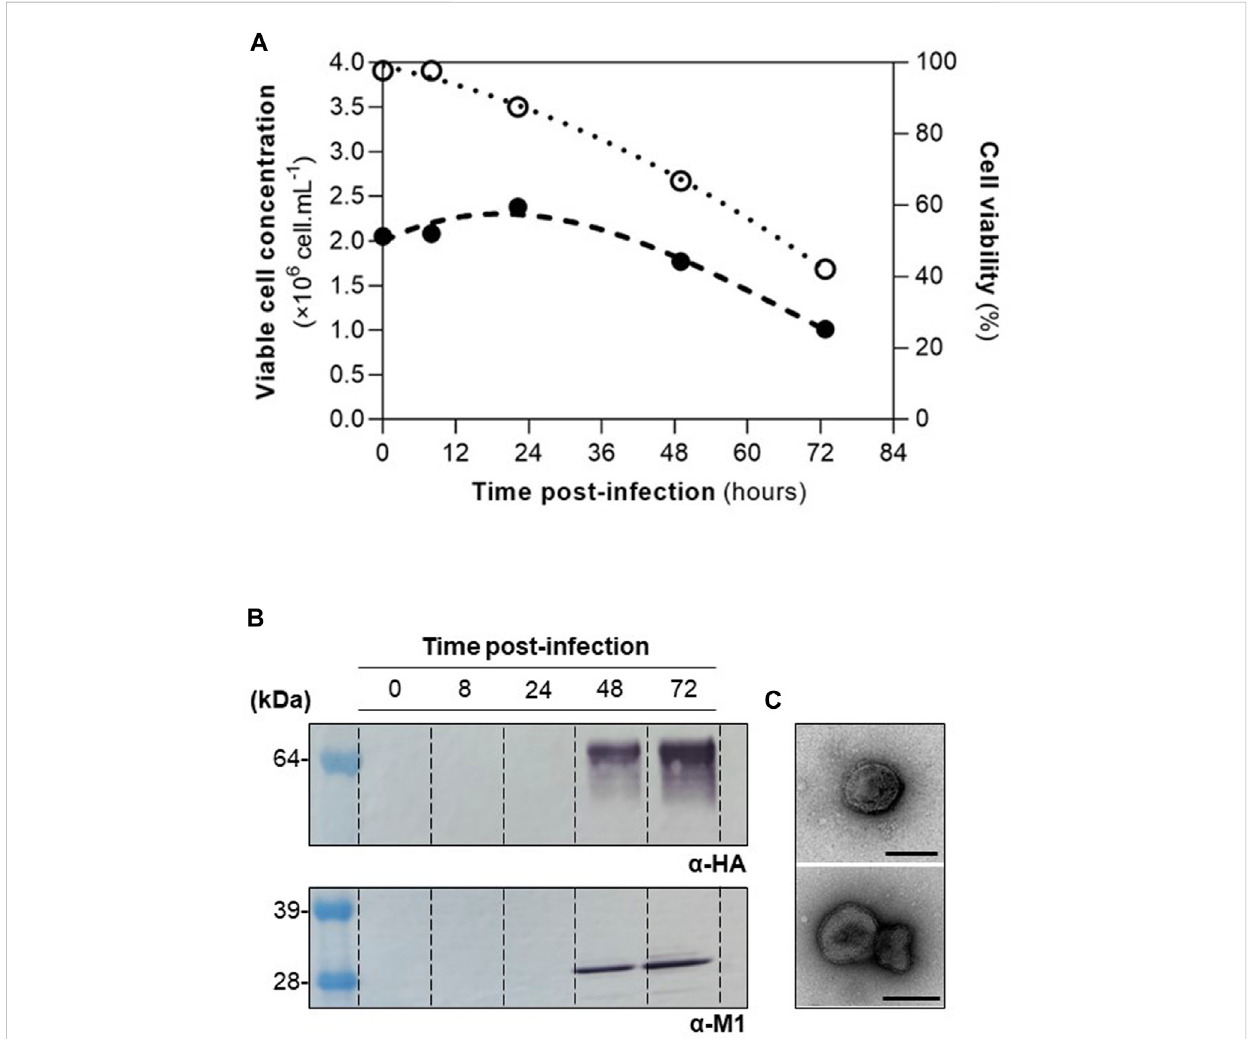
FIGURE 1 Production of in fl uenza HA-VLPs. (A) Cell growth kinetics upon infection. Viable cell concentration and cell viability in full and empty circles, respectively. (B) Identi fi cation of HA and M1 proteins by Western blot. (C) TEM of puri fi ed HA-VLPs; scale bar represents 100 nm.